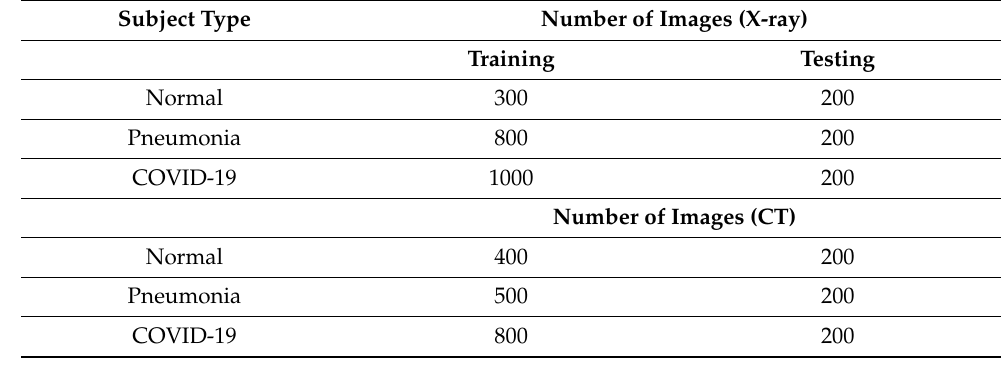
Table 4. Distribution of X-ray and CT images for different contamination types.